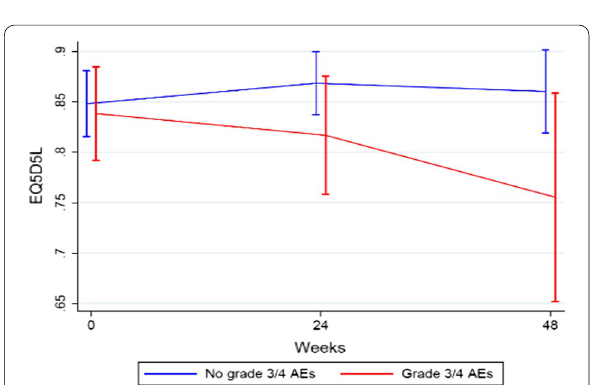
Fig. 2 EQ-5D-5L data for patients in the PROMelanoma study at baseline, week 24 and week 48, comparing the HRQoL between patients with no severe irAEs and patients with severe irAEs